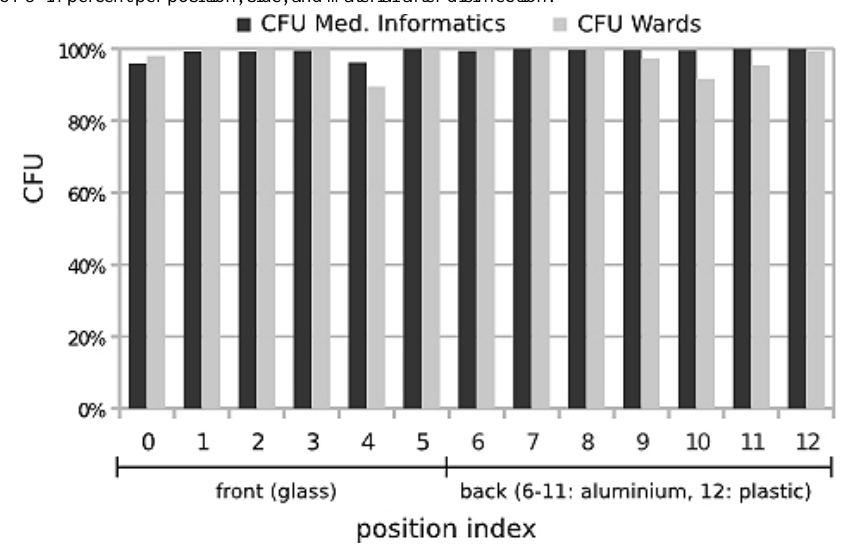
Figure 4. Reduction of CFU in percent per position, side, and material after disinfection.